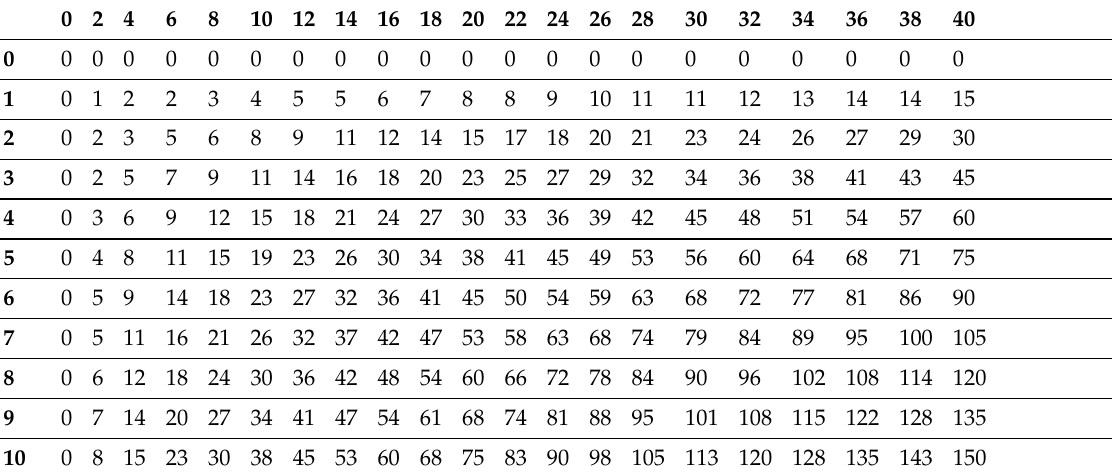
Table 2. Potential income from an investment in the project B per different total amounts of investments in the project B made by the other group members. The leftmost column lists the investments in the project B by the subject, and the uppermost row shows total amounts of investments made by the other group